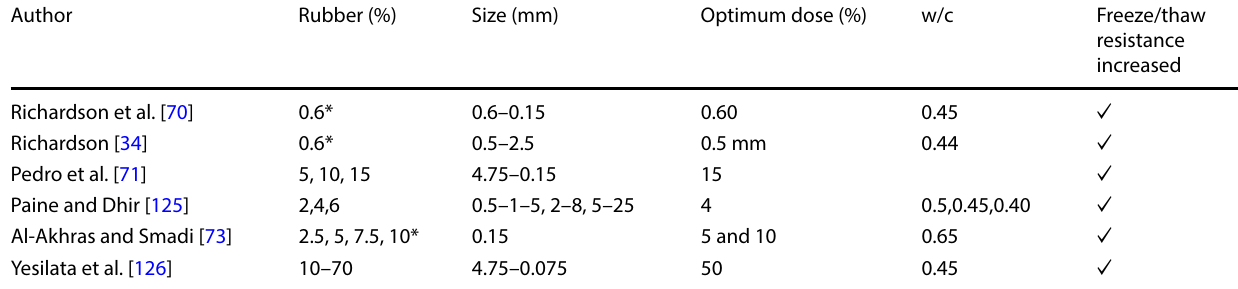
Table 6 Effect of waste recycled tire rubber on freezing and thawing resistance of concrete